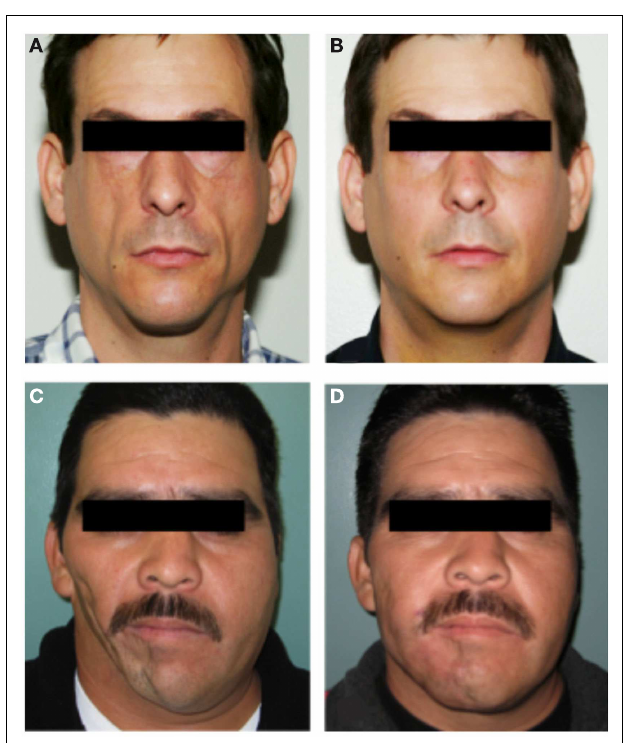
FIGURE 4 |Autologous fat transfer to treat facial soft tissue deficiency. A man with severe HIV lipodystrophy [ (A) , preoperative photo] underwent serial fat grafting to both malar regions [ (B) , post-operative photo].This restored normal facial contour and a more youthful appearance. (C) Preoperative photo of a patient with post-traumatic soft tissue atrophy on the right side of his face had long lasting improvements in facial symmetry after several sessions of fat grafting from the abdomen to the right cheek and jaw region [ (D) , post-operative photo). In both cases lipoaspirate was processed by brief centrifugation and passage through a syringe.The cells within the lipoaspirate were not altered or enriched for specific cell types. Multiple injections of very small quantities of fat were used in each